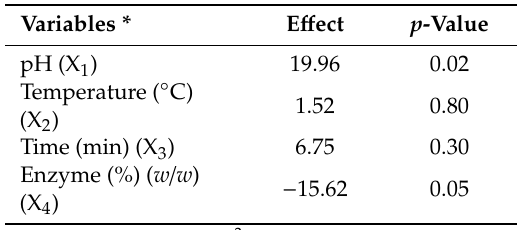
Table 2. Estimated e ff ects of pH, temperature, incubation time, and amount of enzyme on the enzymatic demulsification yield of the cream